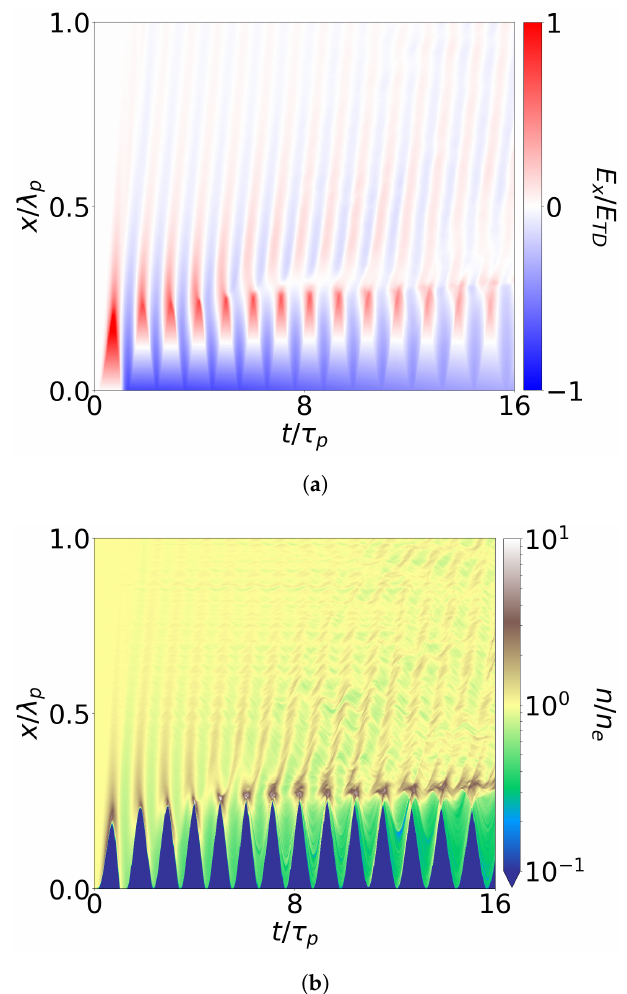
Figure 3. The evolution in space and time of the longitudinal electric field E x ( a ) and electron density n ( b ). The electric field is normalized with respect to the Tajima-Dawson field E TD , and the electron density n is normalized to the initial uniform density n e . The downward arrow on the color bar of ( b ) reflects that n extends to zero in the deep blue areas. The time domain is normalized with respect to the period of plasma oscillation, τ p = 2 π / ω p